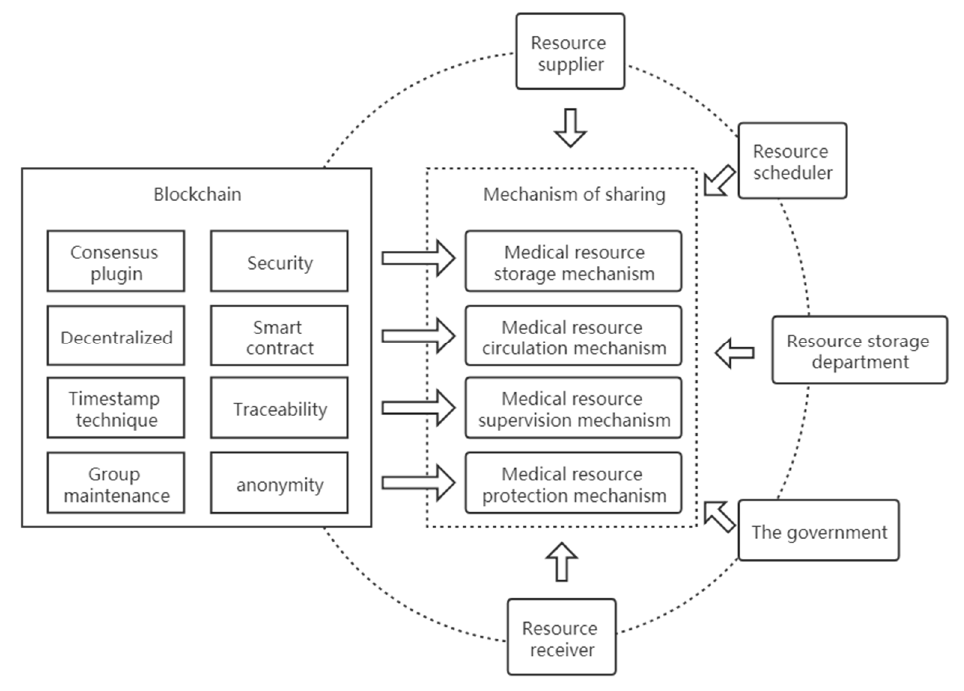
Figure 7. Medical resource sharing mechanism based on blockchain technology.